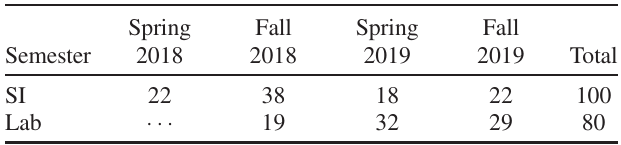
TABLE V. Number of essays analyzed for the General Physics I required lab course and the optional Supplemental Instruction (SI)